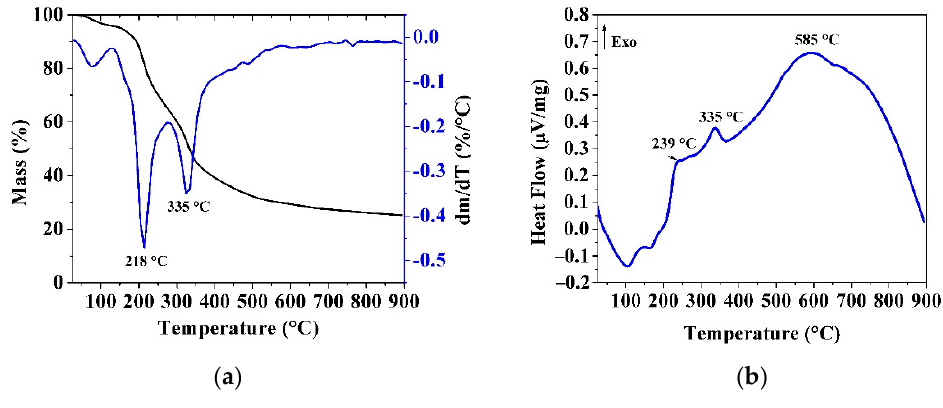
Figure 3. ( a ) TG-DTG curves; ( b ) DSC curves of SOPRAW.